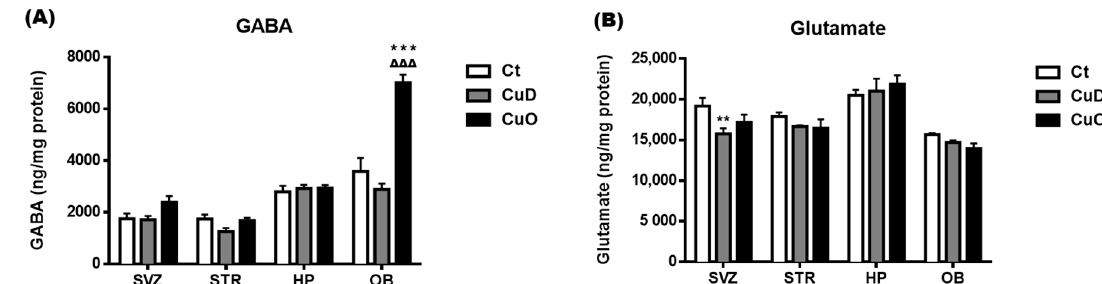
Figure 6. Changes of GABA and glutamate levels in selected brain regions following CuD or CuO treatment. Brain neuroactive amino acids were measured by HPLC. ( A ). Brain regional GABA levels. ( B ) Brain regional glutamate levels. Data represents mean ± SEM, n = 6–7/group. **: p < 0.01, ***: p < 0.001, as compared to the correspondent Ct group; ∆∆∆ : p < 0.001, as compared with the correspondent CuD group; using one-way ANOVA analysis. Ct: control; CuD: Cu deficiency; CuO: Cu overload; SVZ: subventricular zone; STR: striatum; HP: hippocampus; OB: olfactory bulb.